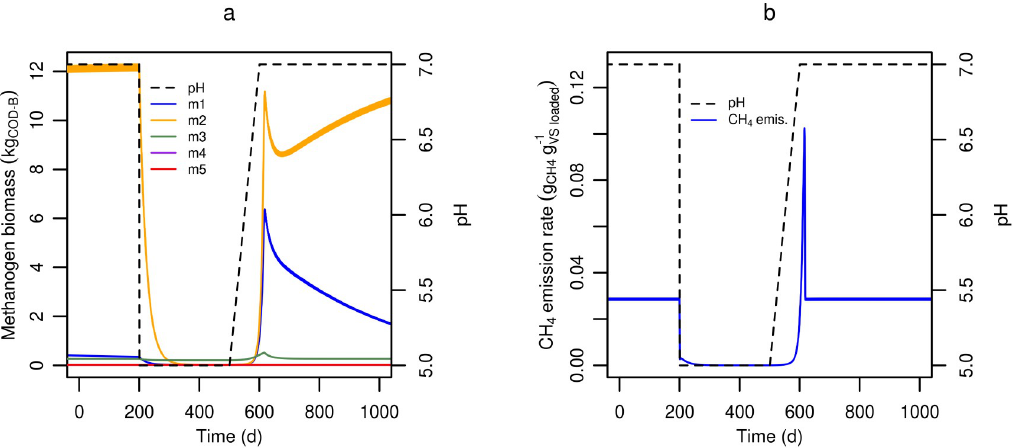
Fig 7. Predicted pH effects on methanogens and methane production. (a) Methanogen biomass and (b) CH 4 emission responses to pH changes. The residual fraction of slurry ( f resid ) was set to 0.95.